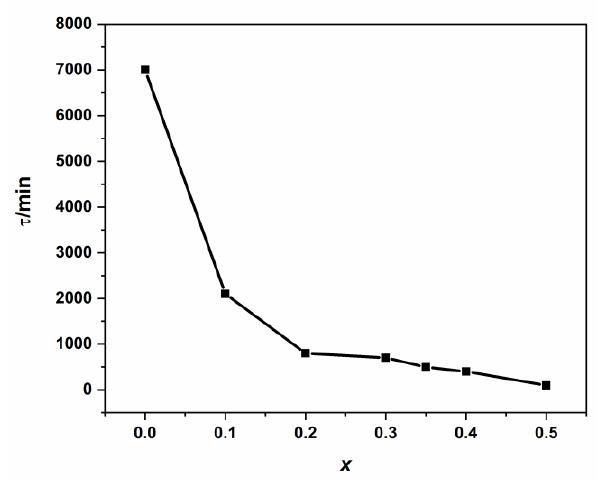
Figure 11. Variation of intra-diffusion time τ vs. cadmium coordination in NSFs.